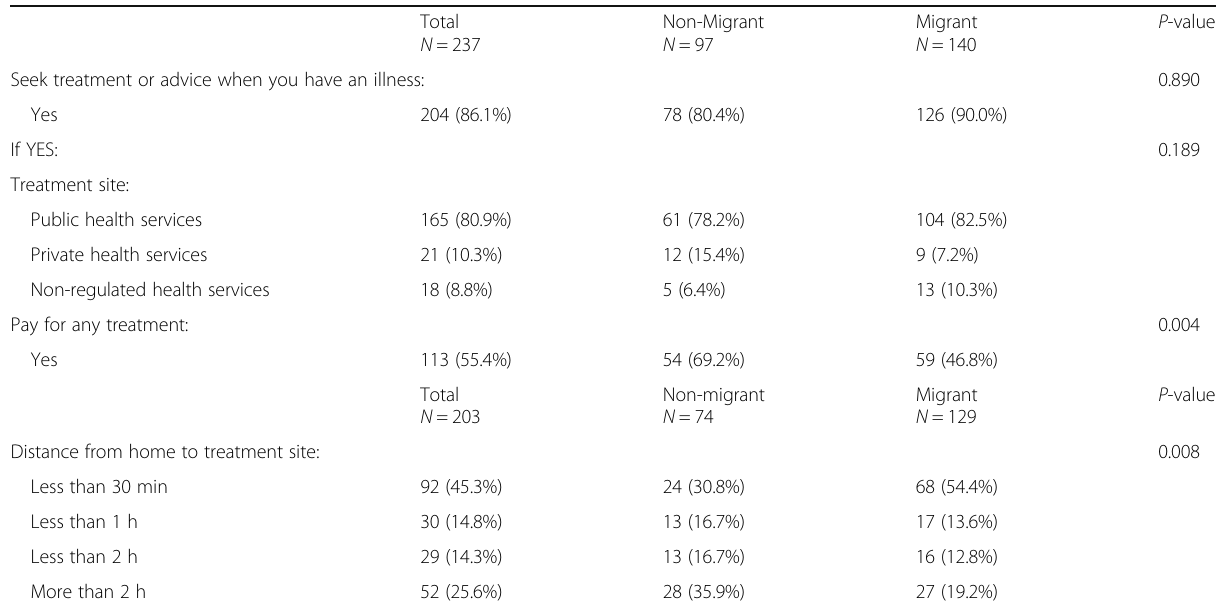
Table 4 Human capital: Wellbeing